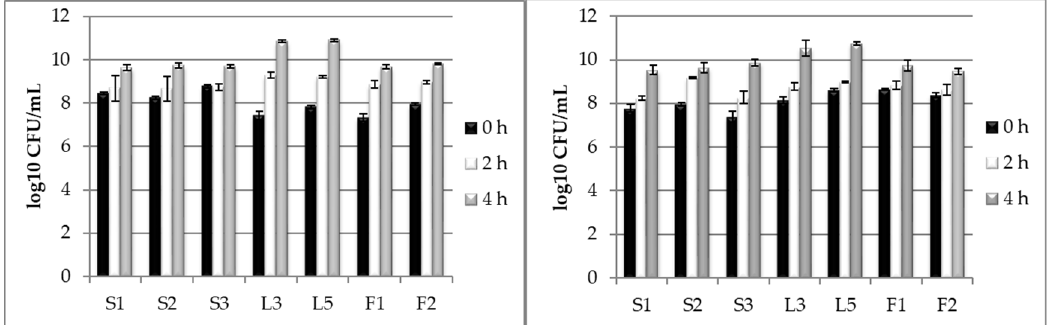
Figure 2. Tolerance of Kombucha LAB isolates to di ff erent bile salts concentration: ( a ) − 0.5%; ( b ) −